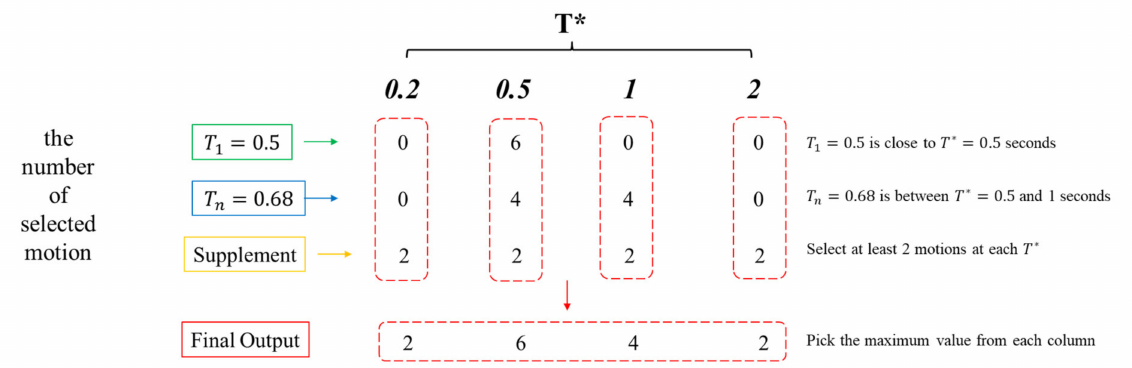
Figure 5. Case Study Output—the number of selected motions at each reference